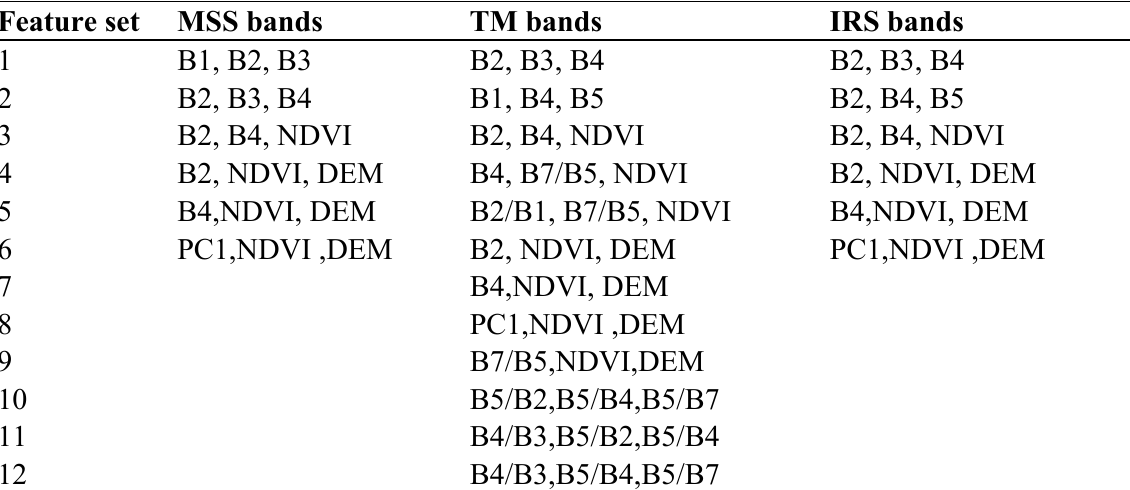
Table 1. Feature sets prepared and